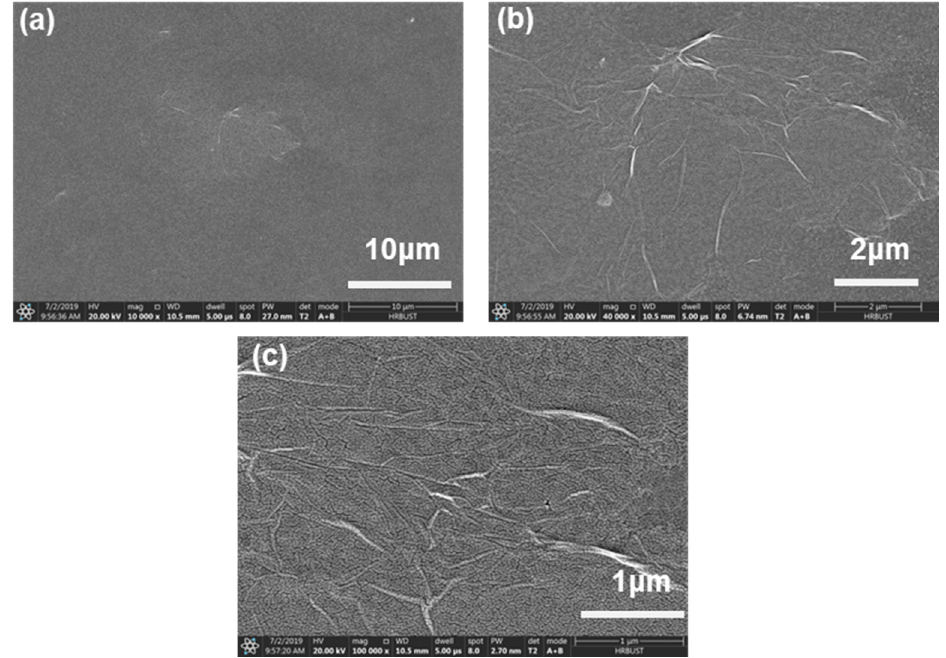
Figure 2. Scanning electron microscopy (SEM) images of the morphology for CS:GO nanocomposite films with the chemical component ratio ( a – c ) 2:1, ( d – f ) 5:1, and ( g – i ) 10:1 w / w , respectively, in terms of distinct magnification 10,000 × , 40,000 × , and 100,000 × , respectively. (HV: 20 kV, WD: 10.4 mm, dWell: 5 µ s).